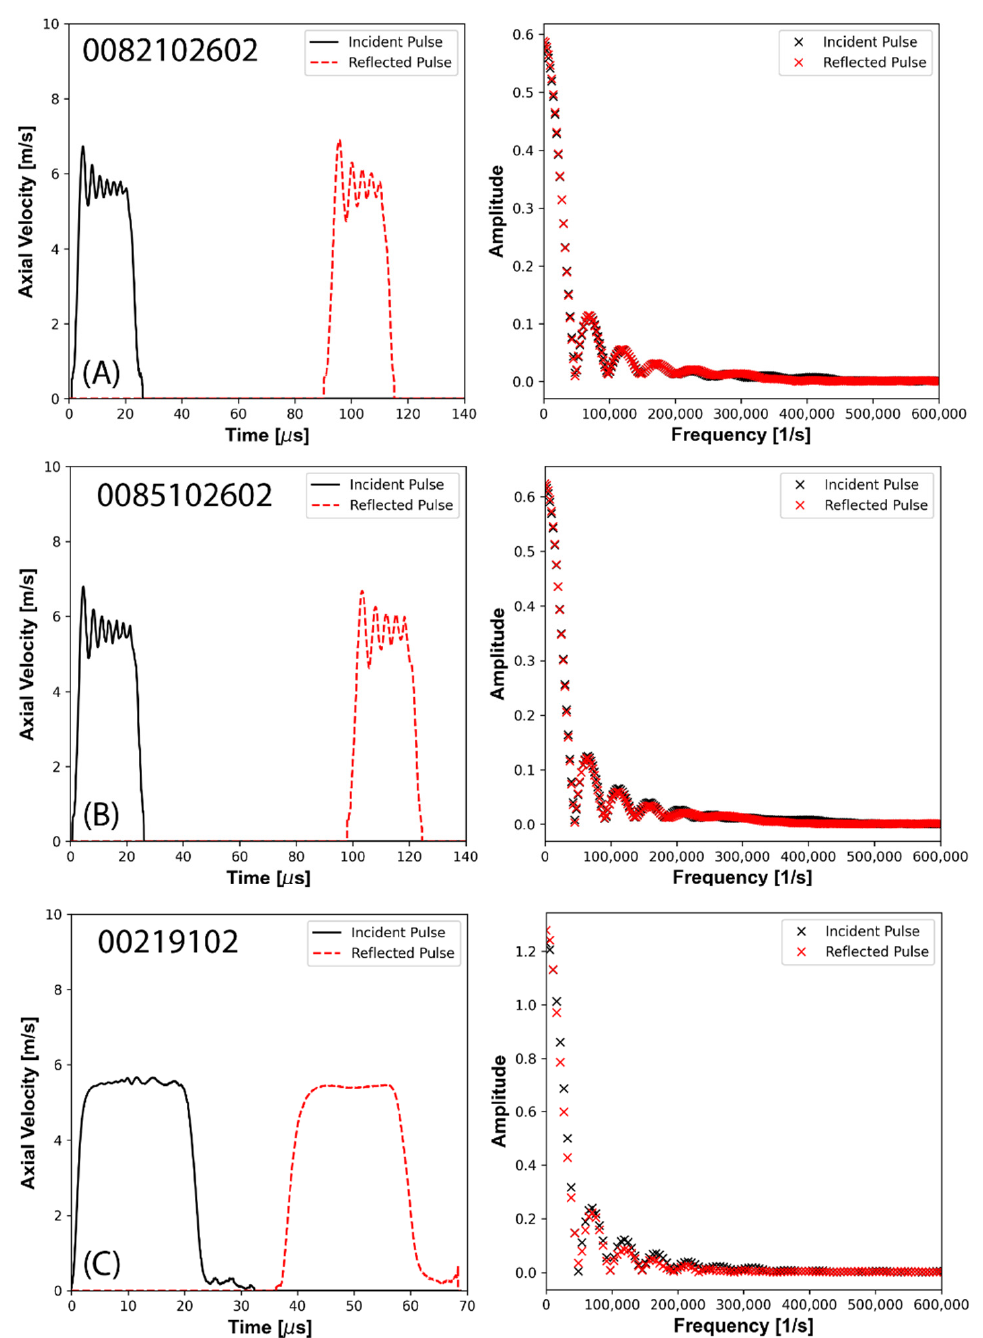
Figure 4. The velocity history and Fourier decomposition of the velocity history into power amplitude versus frequency for ( A ) 7075-T6 aluminum (0082102602), ( B ) C350 maraging steel (0085102602) and ( C ) S200F beryllium (00219102) experiments. The velocity history reveals oscillations on the plateau of the traveling pulses that manifest due to the elastic wave dispersion. These effects are minimized in the Beryllium setup in comparison to aluminum and steel. The Fourier decomposition of the velocity history shows the power amplitude versus frequency of the signal. In the present work, it was possible to resolve and analyze frequencies up to 300–400 KHz.